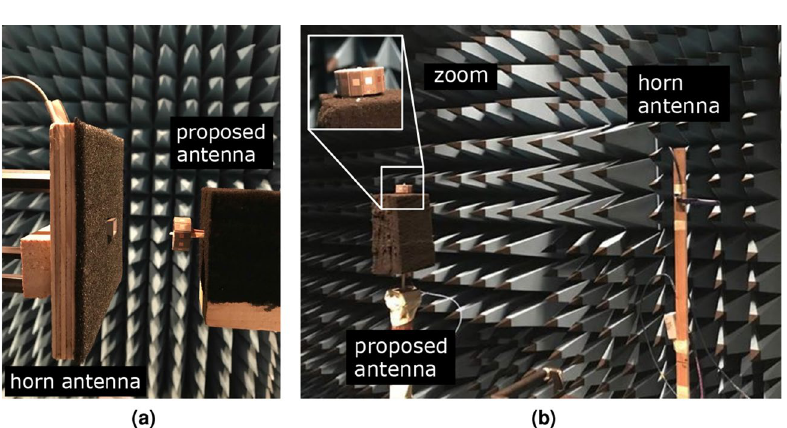
Figure 10. Measurement setup for the near- ( a ) and far-field ( b )